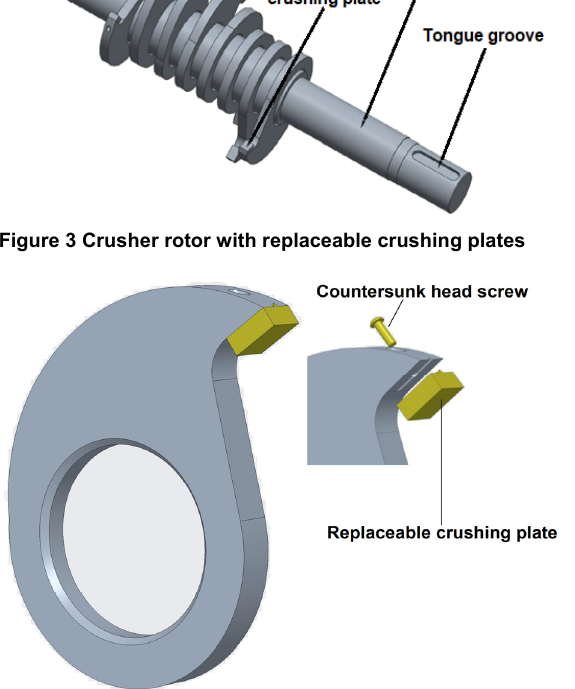
Figure 4 Crushing tool with a replaceable crushing